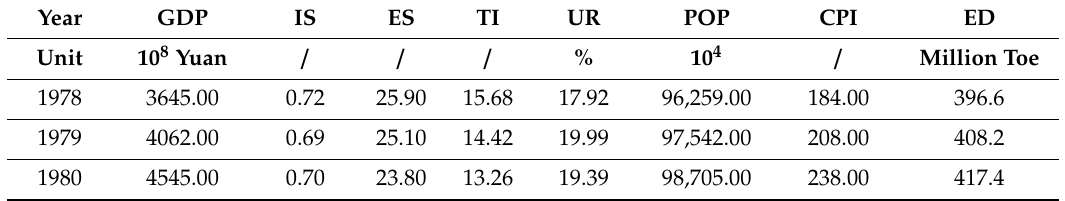
Table A1. Total energy demand and related factors of China between 1978 and